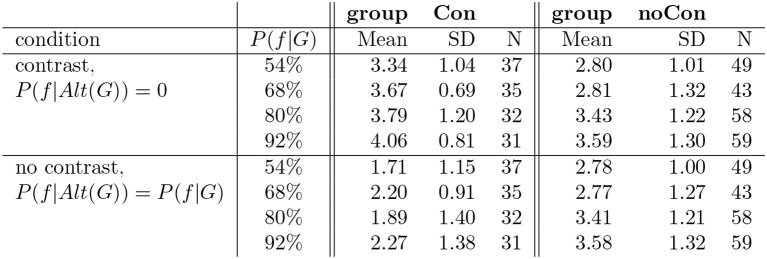
Results of study 3.